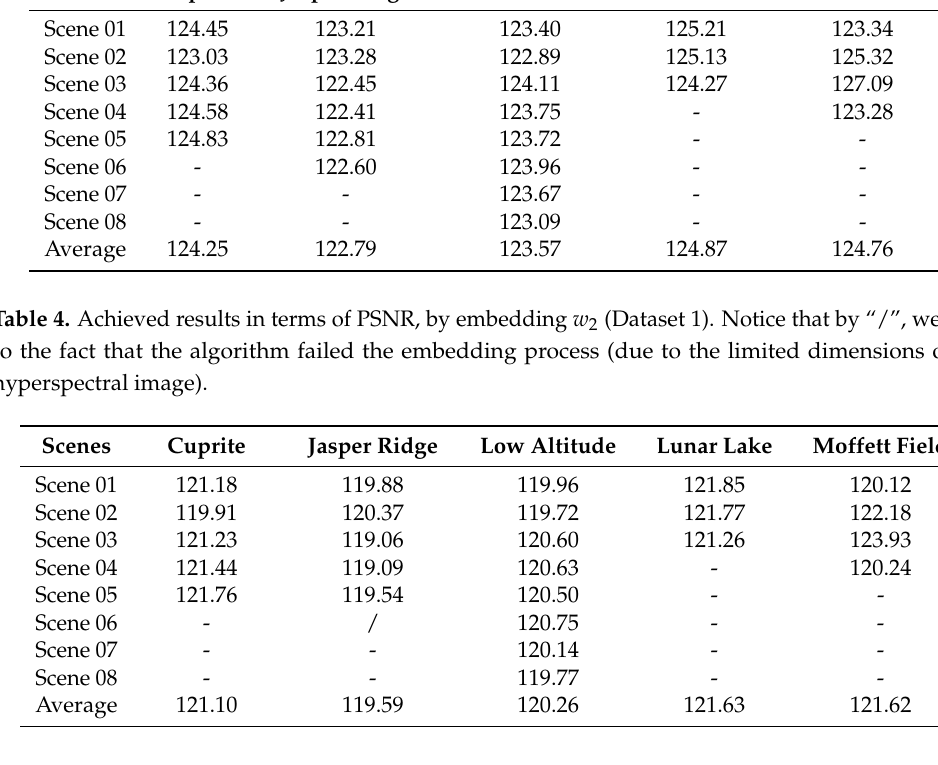
Table 3. Achieved results in terms of PSNR, by embedding w 1 (Dataset 1).